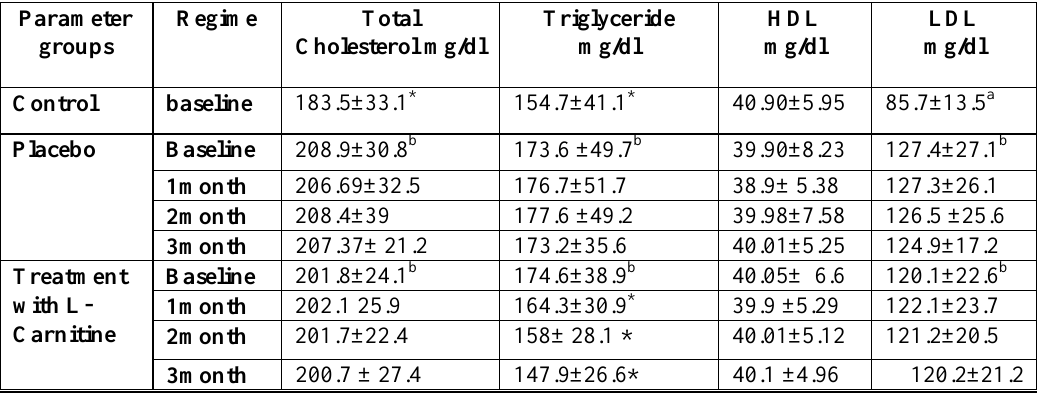
a,b,c represent statistically significant change ( p <0.05) for comparison between healthy group and diabetics ( on placebo or on L-Carnitine ).